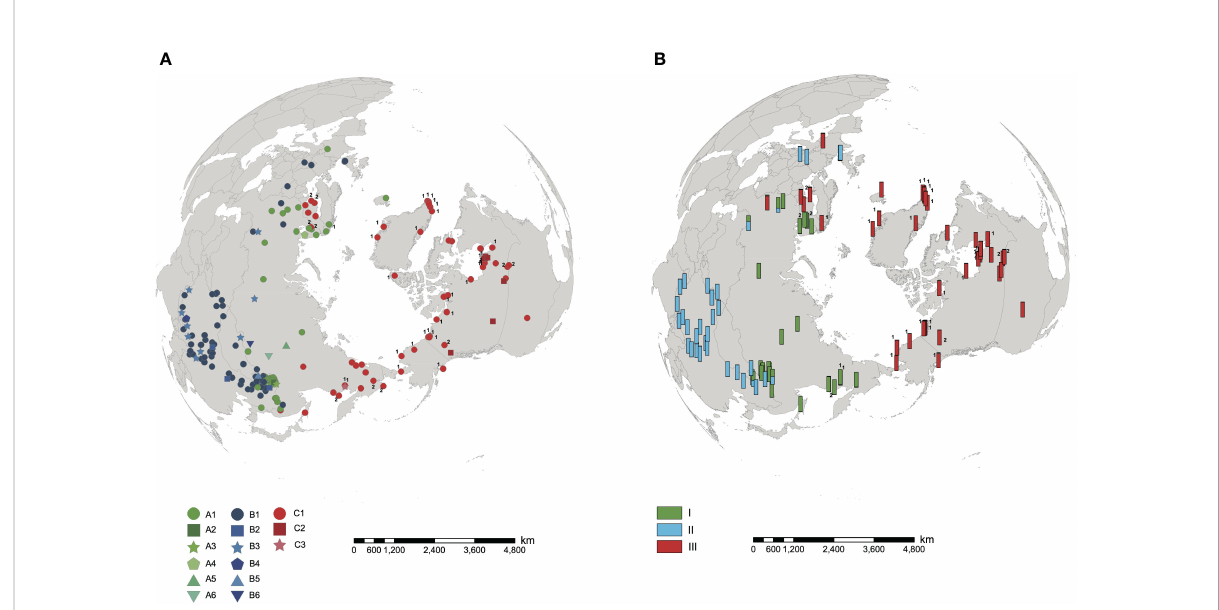
FIGURE 2 Distribution of cpDNA haplotypes and nuclear microsatellite clusters in Hippuris vulgaris . Samples of H. lanceolata and H. tetraphylla were marked with the number 1 and 2, respectively. (A) Distribution of 15 cpDNA haplotypes. (B) Distribution of three nuclear microsatellite clusters identi fi ed using